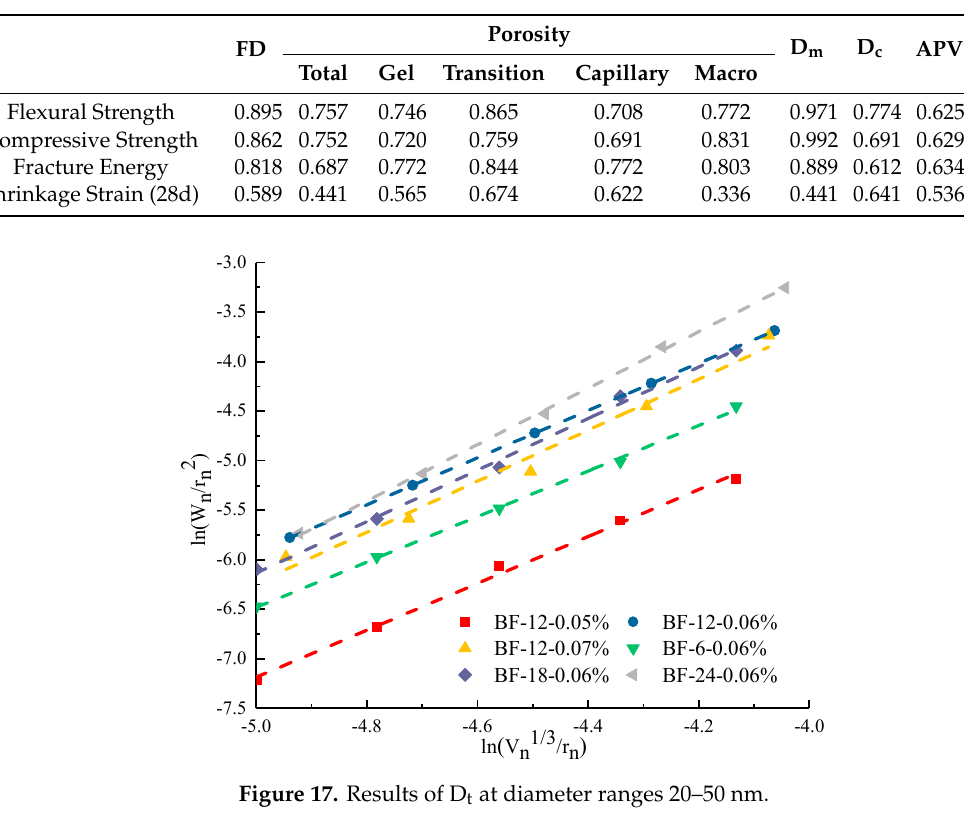
Table 8. Results of average correlation coe ffi cient.